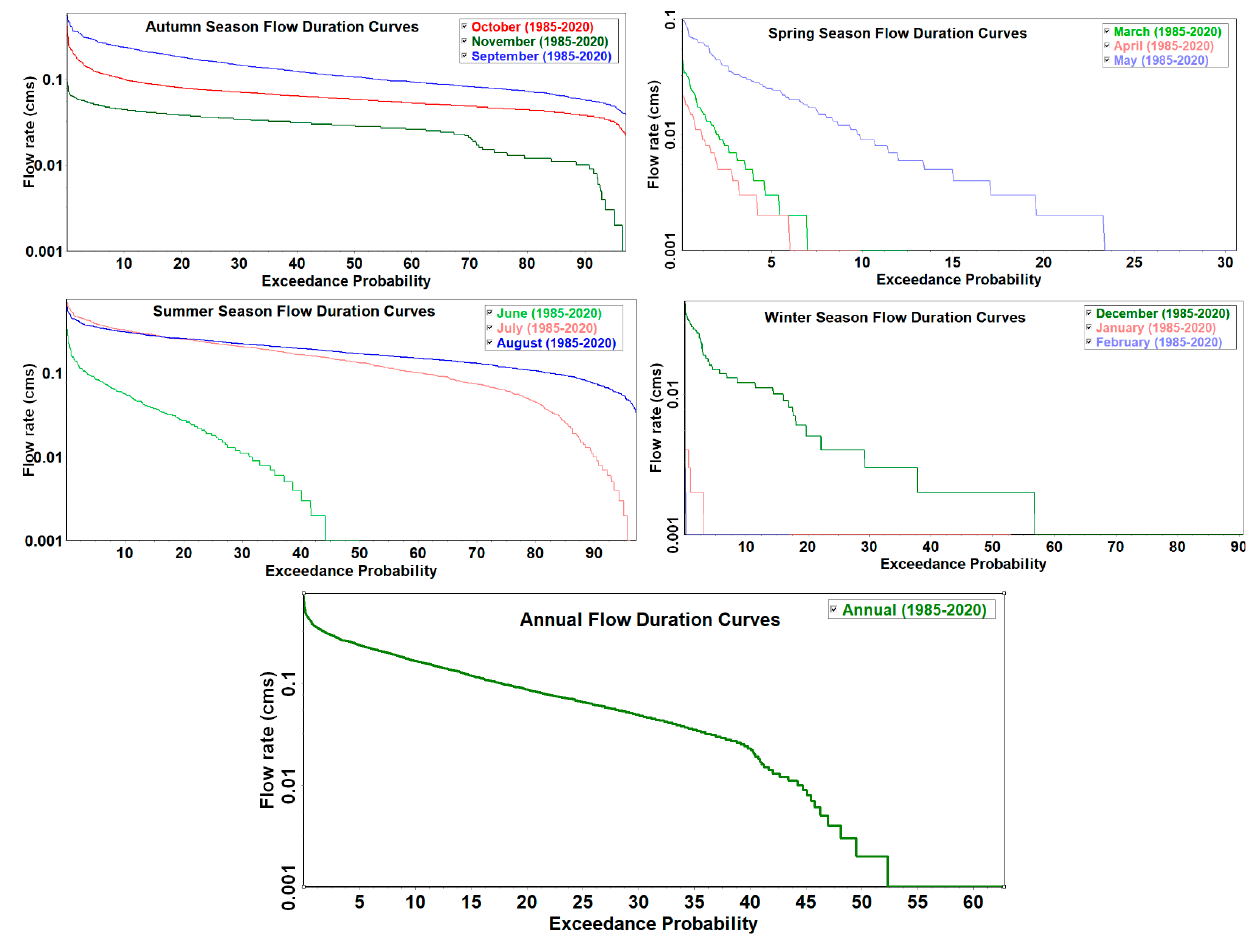
Figure 3. Seasonal and annual flow duration curves.